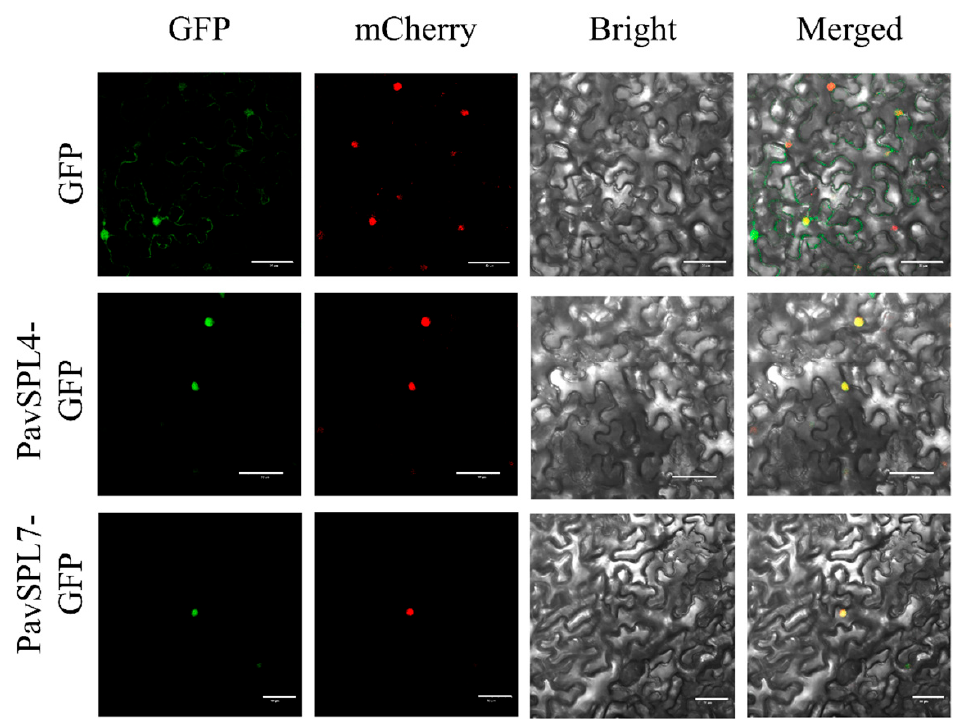
Figure 9. Subcellular localization of PavSPL4 and PavSPL7 proteins. The PavSPL–GFP fusion proteins were transiently expressed in N. benthamiana leaves and the GFP fluorescence signal was observed after 48 h. Scale bar, 50 µm.